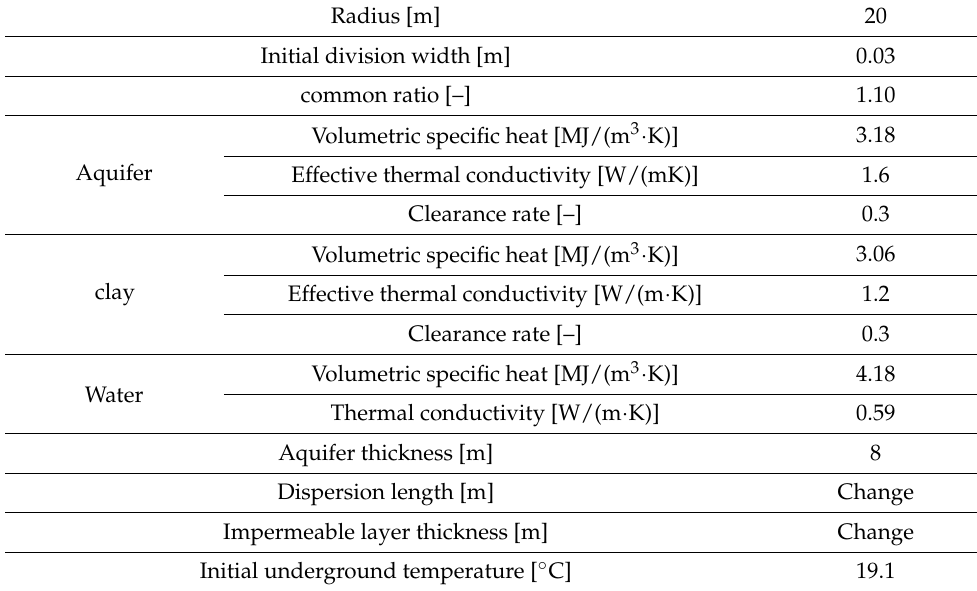
Figure 5. A conceptual diagram of the cylindrical model. Table 1. The cylindrical model input values.